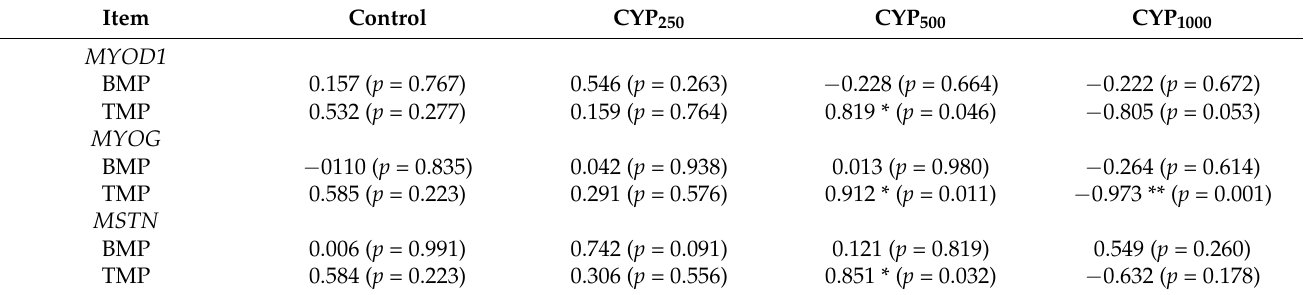
Table 4. The correlation between MYOD1 , MYOG , and MSTN mRNA expression of thigh muscle and BMP or